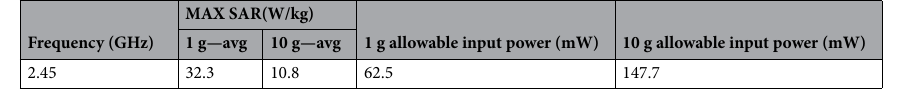
Table 2. Peak spatial average SAR (input power = 1 W) and maximum allowable input power.